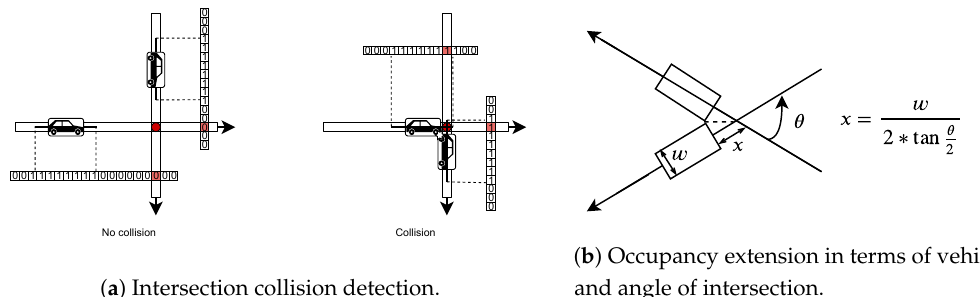
Figure 7. Intersection collision detection logic and occupancy extension to model vehicle width and angle of intersection